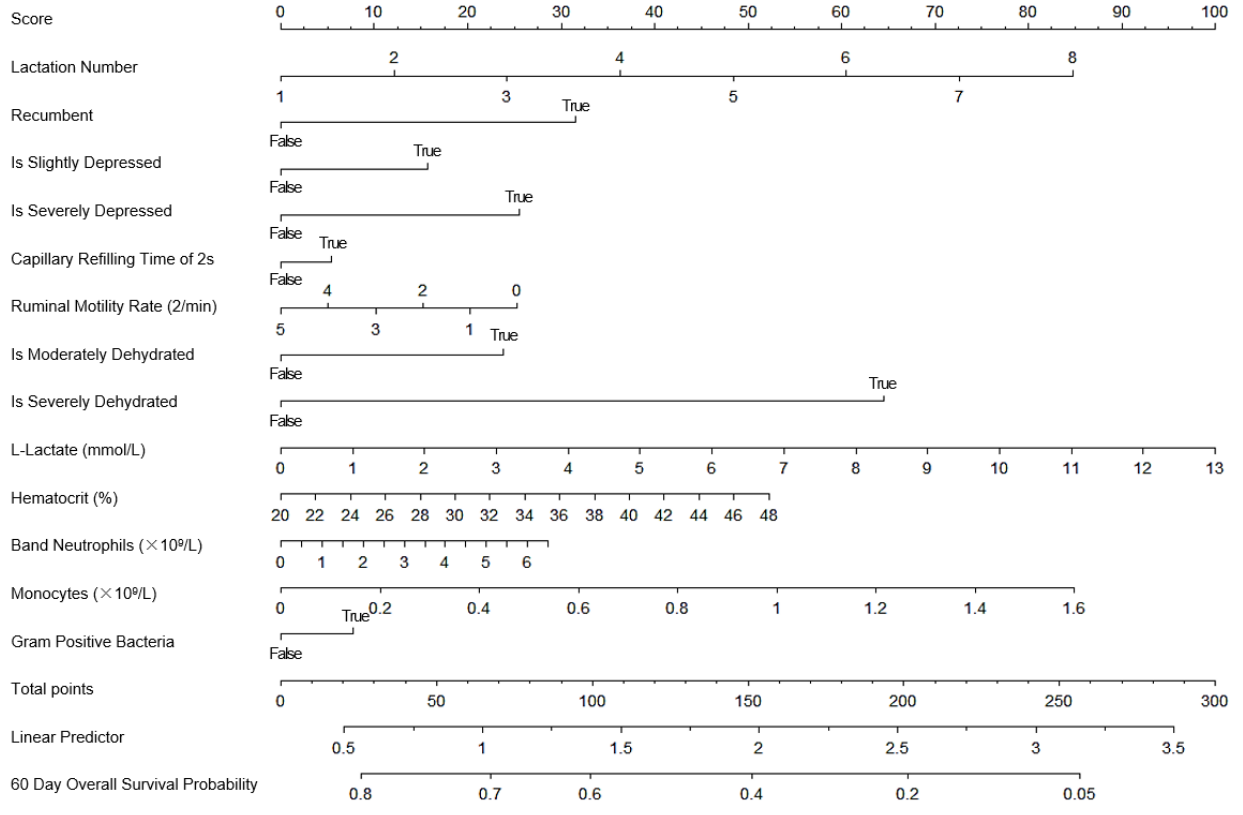
Figure 1. Nomogram with all predictors for predicting 60-day survival of dairy cows coming from 124 herds in Québec, Canada affected by severe clinical mastitis at first veterinary visit. The C-index of the nomogram was 0.71 ± 0.01, and the tAUC is presented in Figure 2. These two metrics show that the discriminatory abilities of the first nomogram were good (tAUC of 0.8) in the first 10 days after enrollment but decreased afterwards (tAUC of 0.65 around day 50). Overall, the discriminatory abilities of the nomogram were fair to good (C-index and tAUC). We can conclude that the nomogram is able to predict survival from non-survival better than chance.